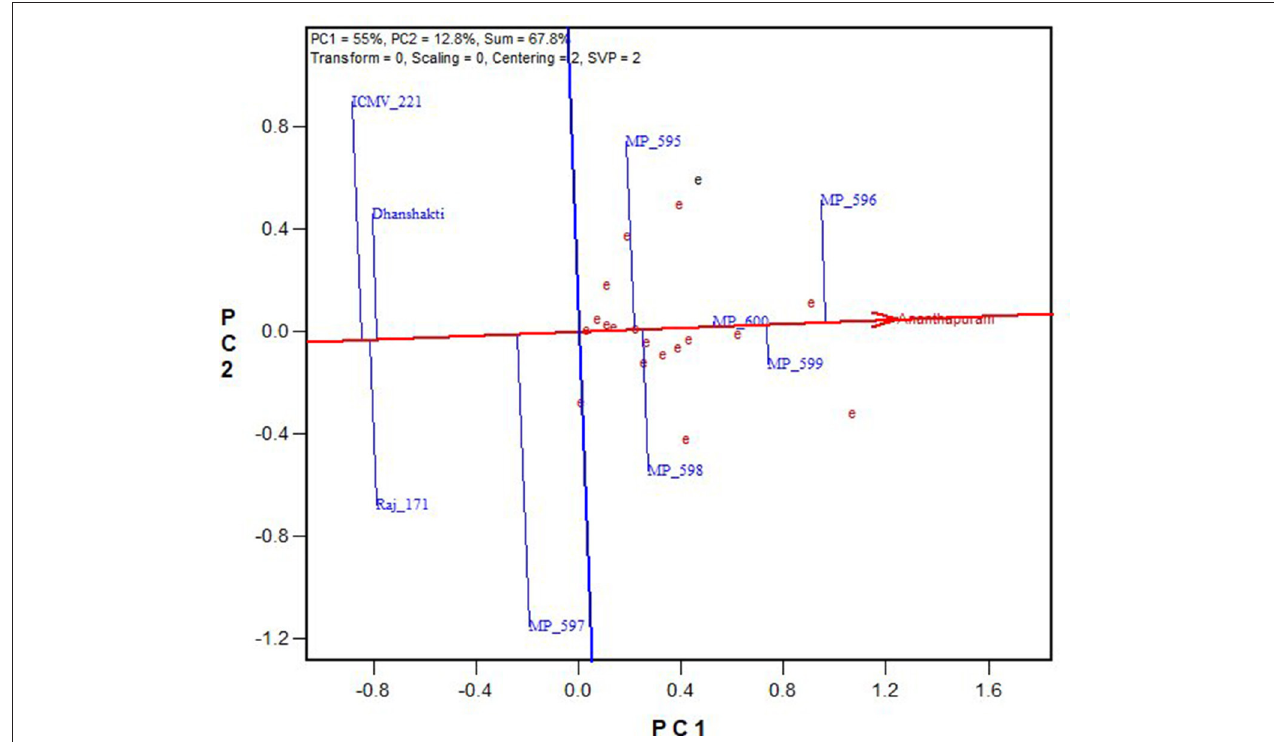
FIGURE 5 | Ranking of genotypes based on their performance for grain yield in near-ideal location, Ananthapuramu.